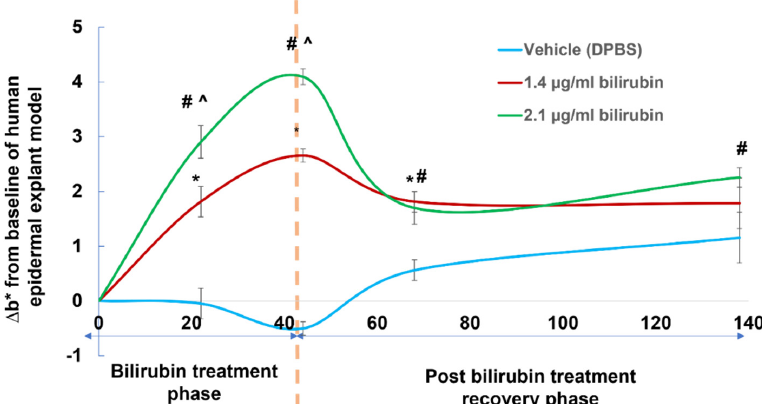
Figure 6. Human epidermal skin explants were cultured with vehicle, 1.4 µg/mL bilirubin or 2.1 µg/mL of bilirubin for 44 h (treatment phase). At 44 h, the bilirubin treatments were replaced with DPBS vehicle without bilirubin and epidermal skin samples were equilibrated till 138 h (recovery phase). Data indicate mean ± SEM. n = 6/group. *; p < 0.05 of 1.4 µg/mL bilirubin leg vs. vehicle-treated control sample. #; p < 0.05 of 2.1 µg/mL bilirubin leg vs. vehicle-treated control sample. ^; p < 0.05 for 2.1 µg/mL group vs. 1.4 µg/mL group.